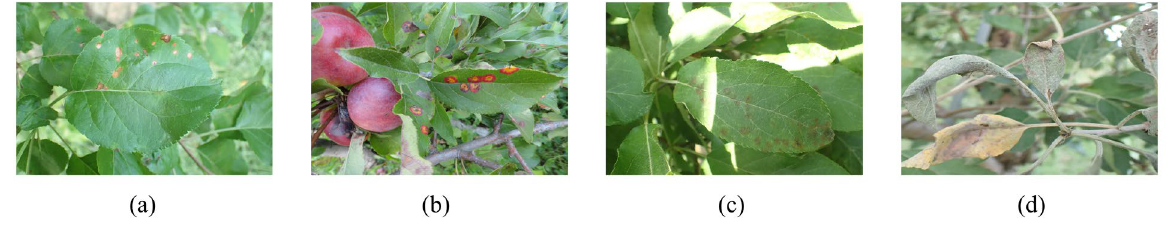
Figure 1. FGVC7 and FGVC8 disease images. ( a ) Frogeye leaf spot; ( b ) Rust; ( c ) Scab; ( d ) Powdery mildew.